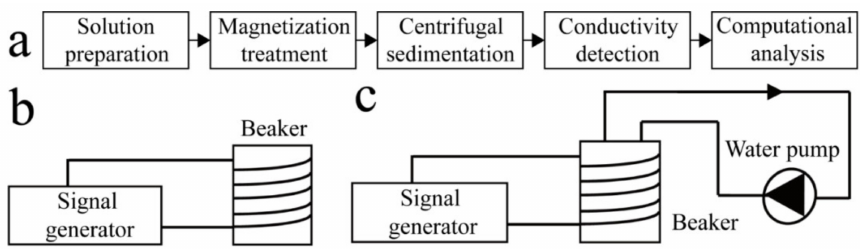
Figure 1. A schematic diagram of a parallel magnetic field anti-scaling test system. ( a ) Magnetization anti-scaling test process; ( b ) Static water condition; ( c ) Dynamic water